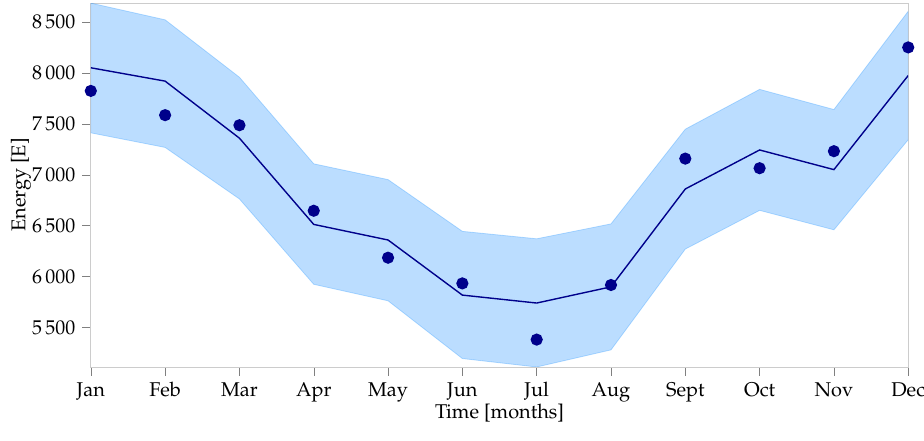
Figure 4. Measured data with overlaid Bayesian baseline model and its 95% HDI.